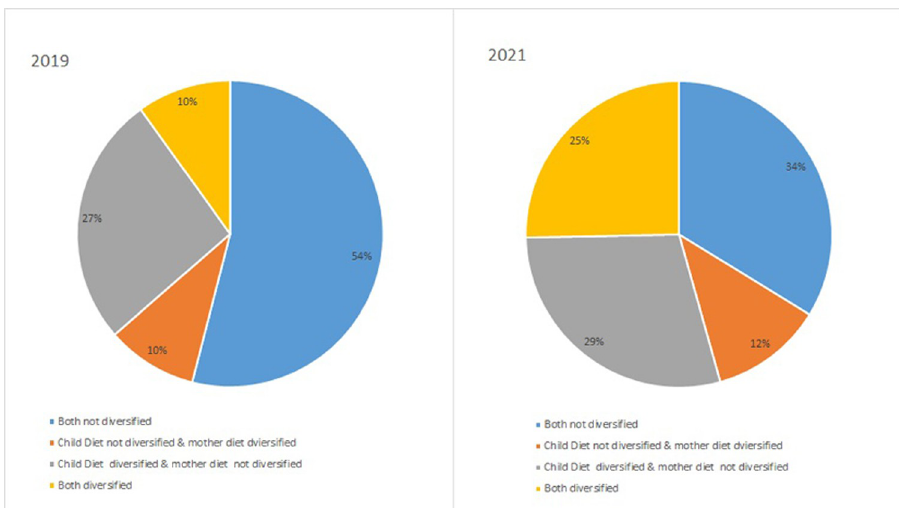
Fig 2. Dietary diversity status among mother-child dyads, Gadchiroli and Chandrapur, 2019 and 2021.